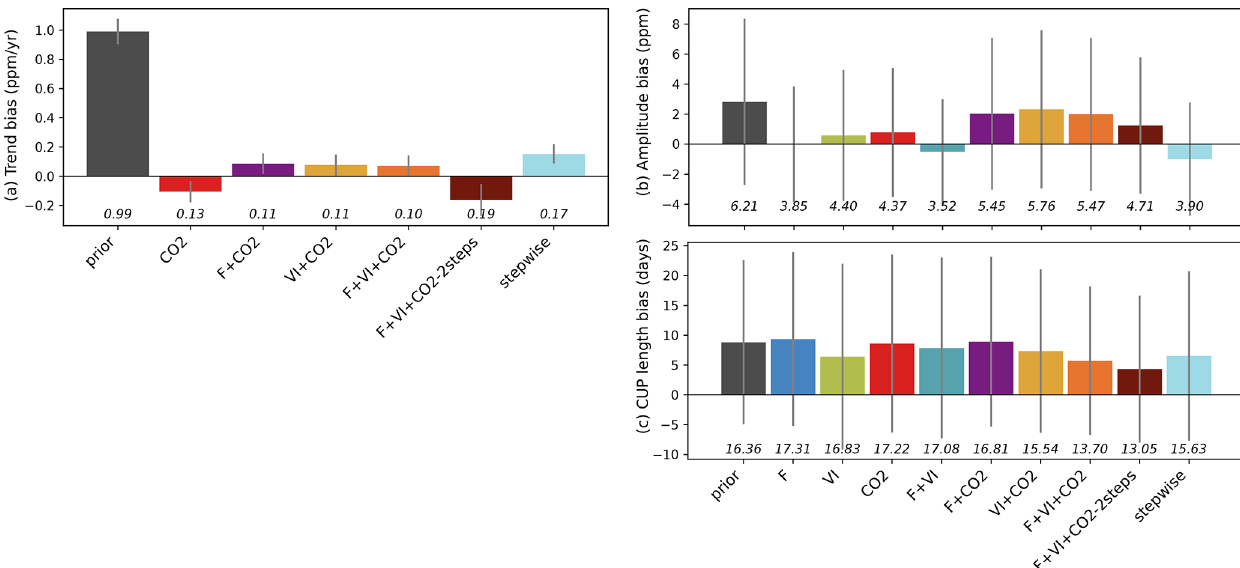
Figure 3. Residual biases of the atmospheric CO 2 time series between those measured at stations and the simulations (prior and optimized for each assimilation experiment), in terms of trend, magnitude of the seasonal cycle and length of the carbon uptake (CUP). The study results are compared to those obtained using a sequential approach (Peylin et al., 2016). The bars show for each quantity the mean bias relative to the measurements over the period 2000–2009. The standard deviations of the differences between observations and simulations over all stations are shown as the vertical gray lines, and the RMSDs are provided below in